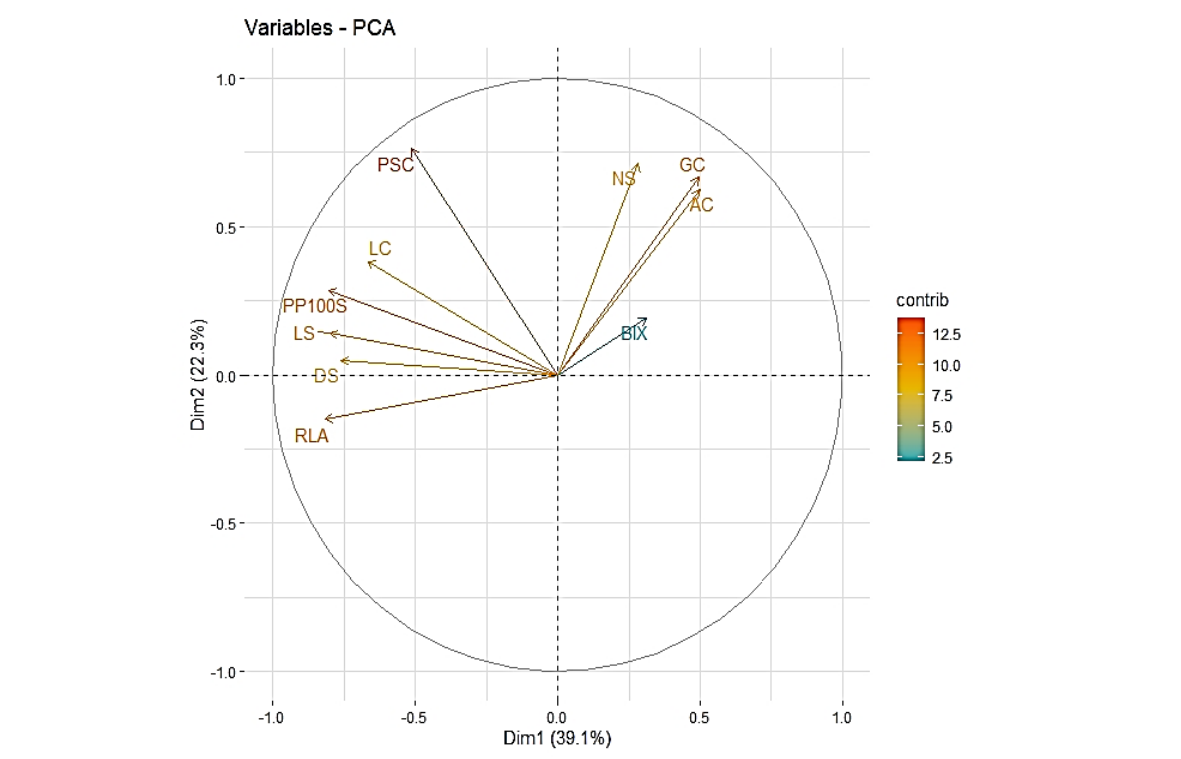
Figure 2 . Contributions of the achiote descriptors* as determined by the two principal component axes.